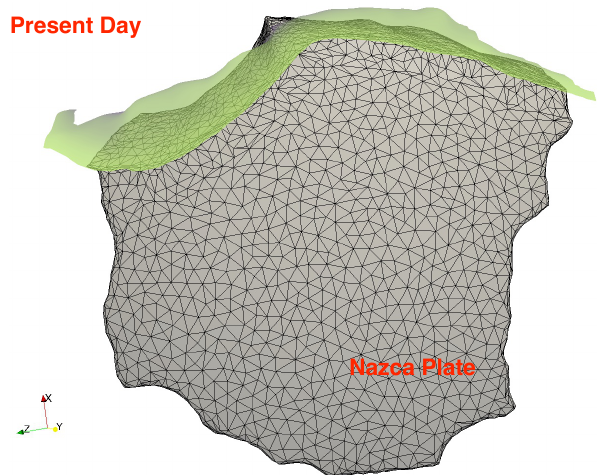
Figure A1. Top-down view of the Nazca plate at present day for geodynamic model input. The green to purple coloured topology represents the depth of the Nazca slab from the Slab1.0 (Hayes et al., 2012) interpretation. The black mesh over the plate indi- cates the resolution of the model. The Slab1.0 interpretation is made slightly transparent to see the extent of modelled plate.